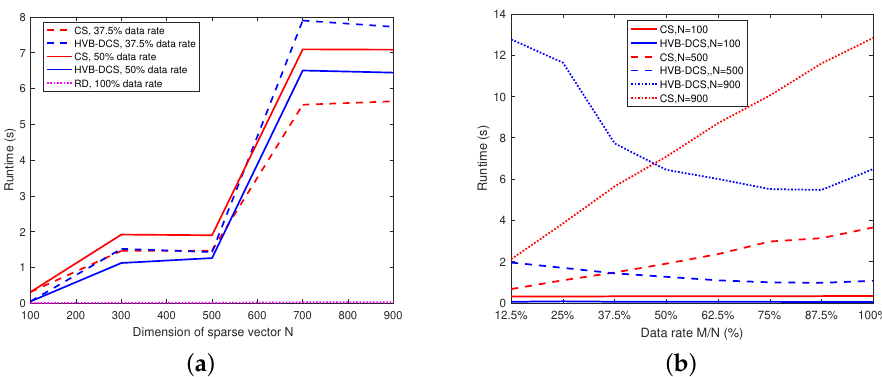
Figure 16. Complexity comparisons of the RD, CS and HVB-DCS algorithms: ( a ) runtime versus sparse vector dimension N ; ( b ) runtime versus data rate M / N .